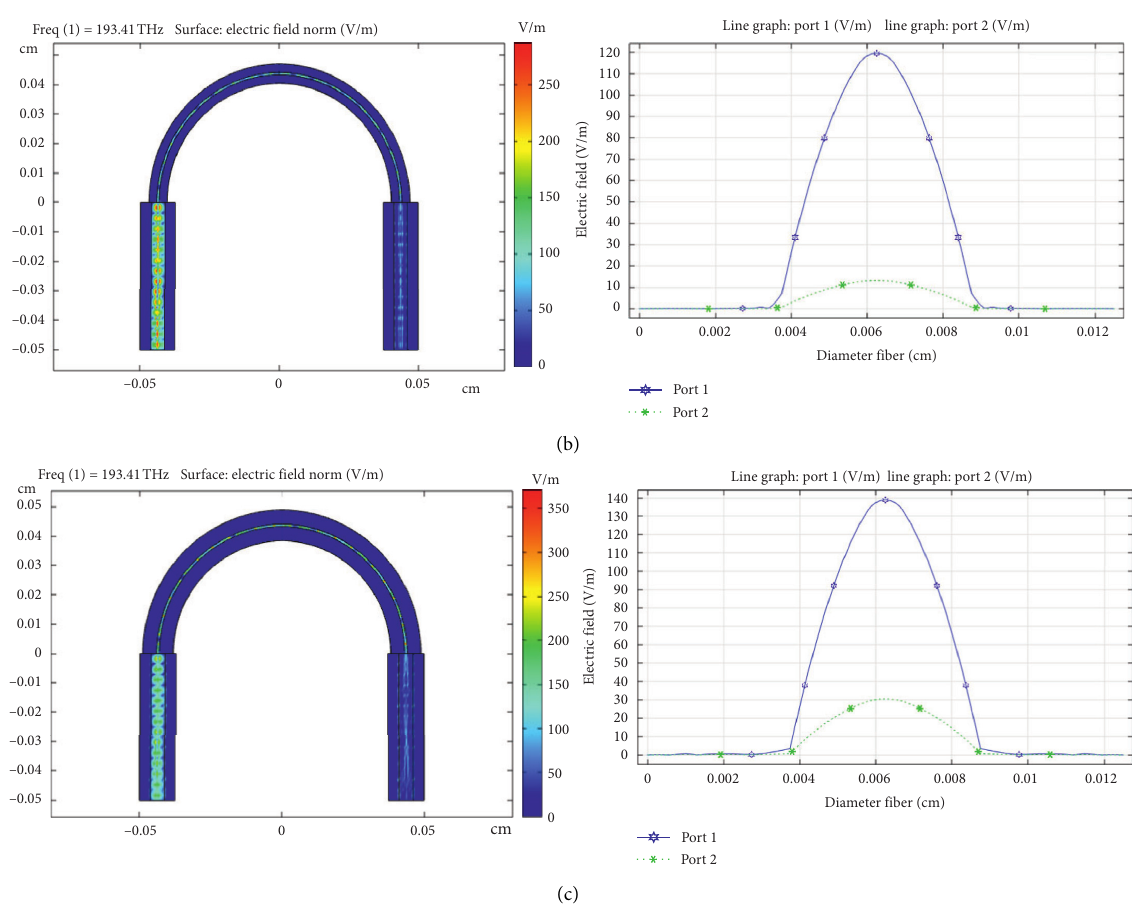
Figure 5: Electric field and power flow for cladding diameter of ZnO film. (a) 25 μ m, (b) 65 μ m, and (c) 105 μ m.